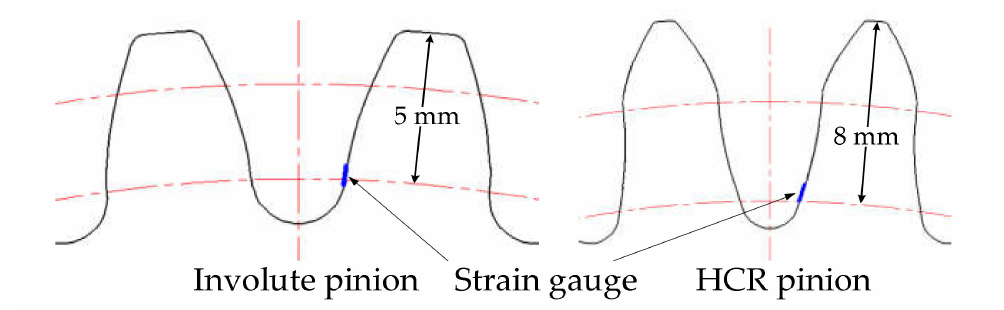
Figure 17. Schematic diagram of strain gauge